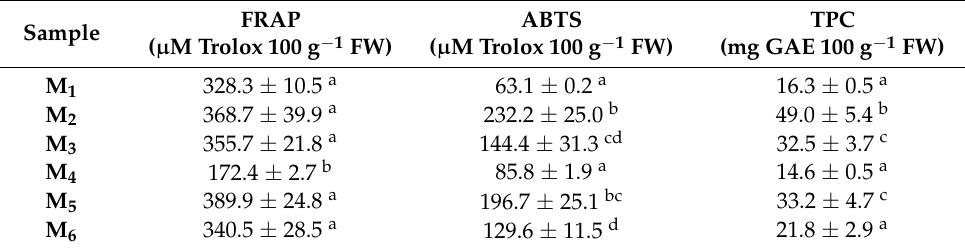
Table 4. Antioxidant activity results measured by FRAP and ABTS methods and the TPC values of the celery wastes studied expressed as average quantities ± standard deviations ( n = 3).